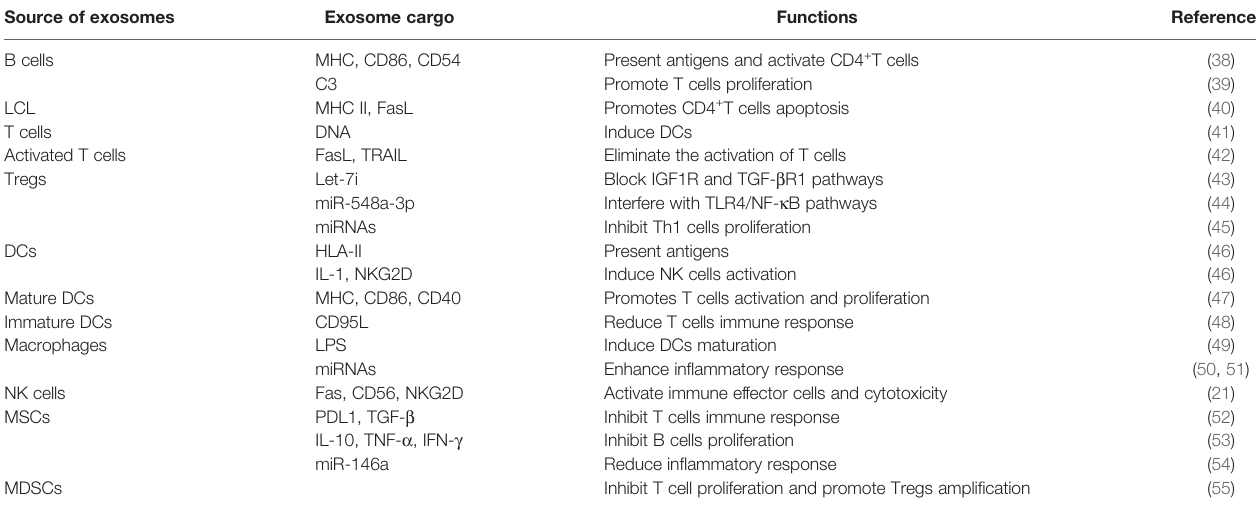
TABLE 1 | Exosomes derived from various cells and their immune roles. Source of